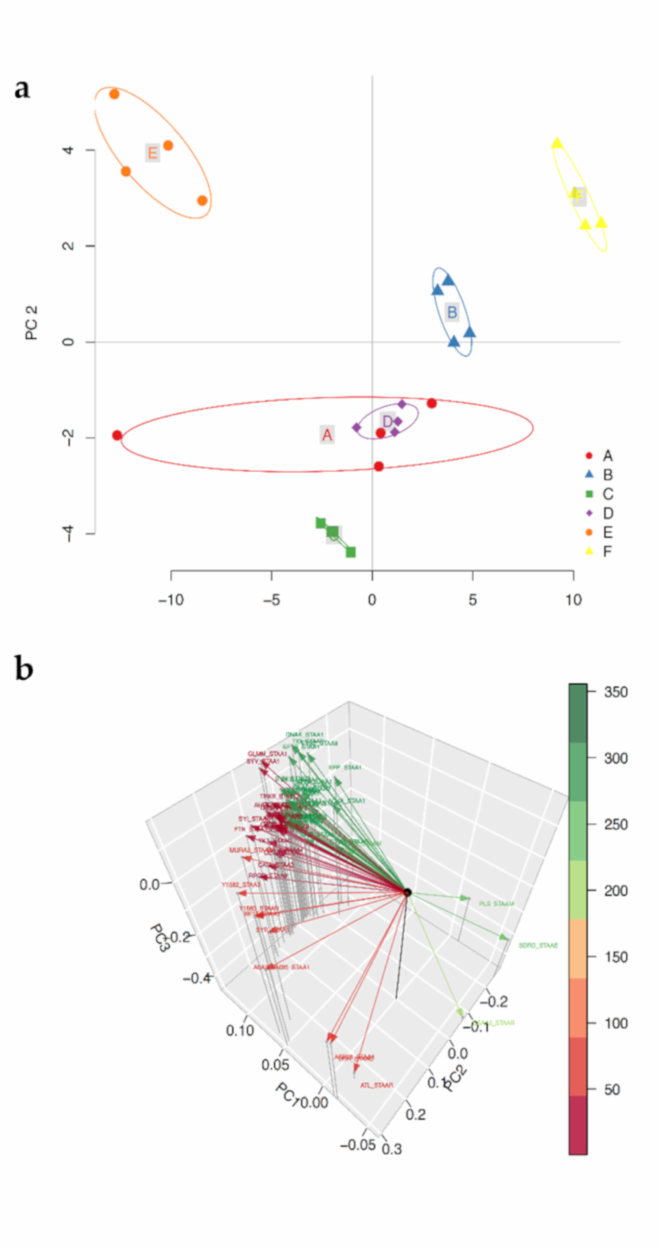
Figure 4. ( a ) PCA analysis of the di ff erentially regulated proteins’ (A) control cultures grown under ideal conditions at pH 7 and 37 ◦ C with no added NaCl; (B) the centroid cultures grown at pH 7 and 37 ◦ C with additional 2.5% NaCl, and the four experimental groups: (C) 35 ◦ C and pH 6 with no added NaCl; (D) 35 ◦ C and pH 8 with no added NaCl; (E) 35 ◦ C and pH 6 with 5% NaCl added; (F) 35 ◦ C and pH 8 with 5% NaCl. ( b ) The loadings PC1, PC2, and PC3 demonstrated the contributions of the proteins to the